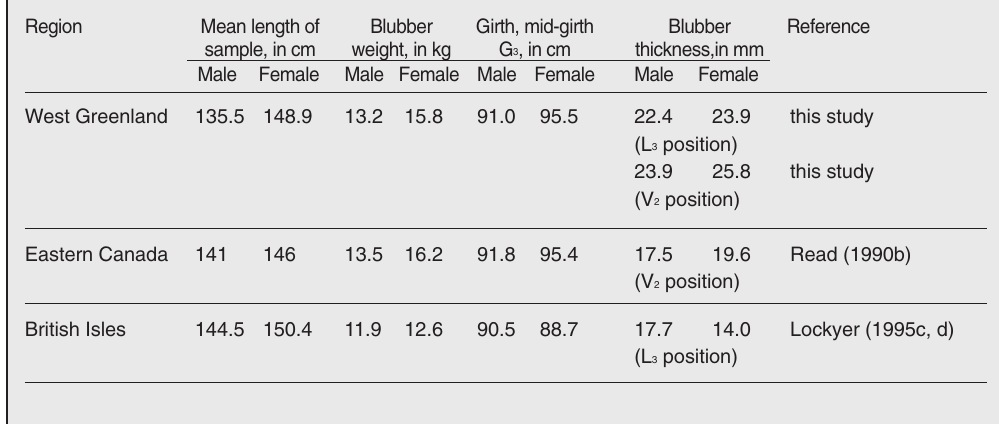
Table 6. Measurements (means) for adult porpoises. Females include pregnant but not lac- tating, and lactating and pregnant